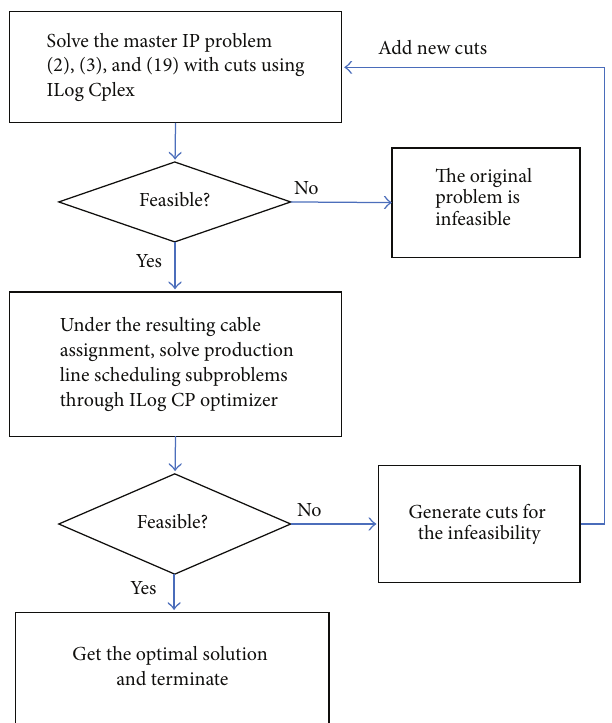
Figure 3: Illustration of the hybrid MILP/CP